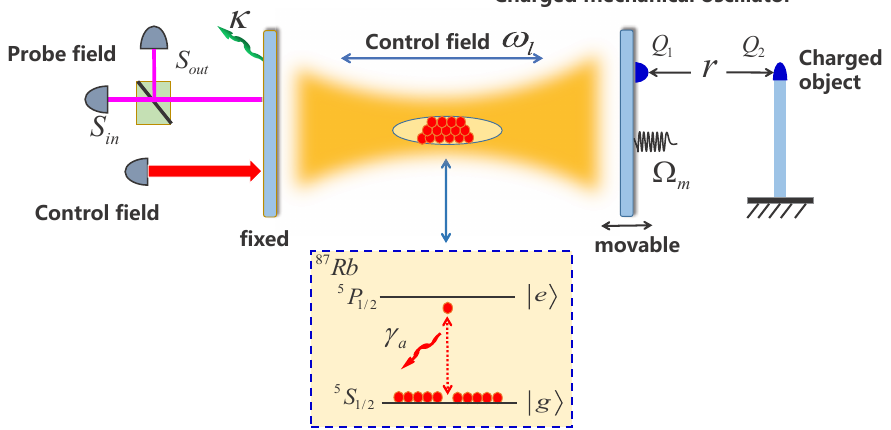
Figure 1. Schematic diagram of a hybrid optomechanical system, in which an ensemble of N identical two-level 87 Rb atoms, with transition frequency ω a and decay rate γ a , are embedded in the cavity field. Levels | g (cid:105) and | e (cid:105) correspond to the ground state | 5 S 1/2 (cid:105) and the excited state | 5 p 1/2 (cid:105) of the 87 Rb atom, respectively. The system is driven by a strong control field with frequency ω l and probed by a weak probe field with frequency ω p . The transmission of the output field can be measured by the homodyne technique [36]. A charged mechanical oscillator with angular frequency Ω m and charge amount Q 1 is coupled to an adjoining charged object with charge amount Q 2 via the Coulomb